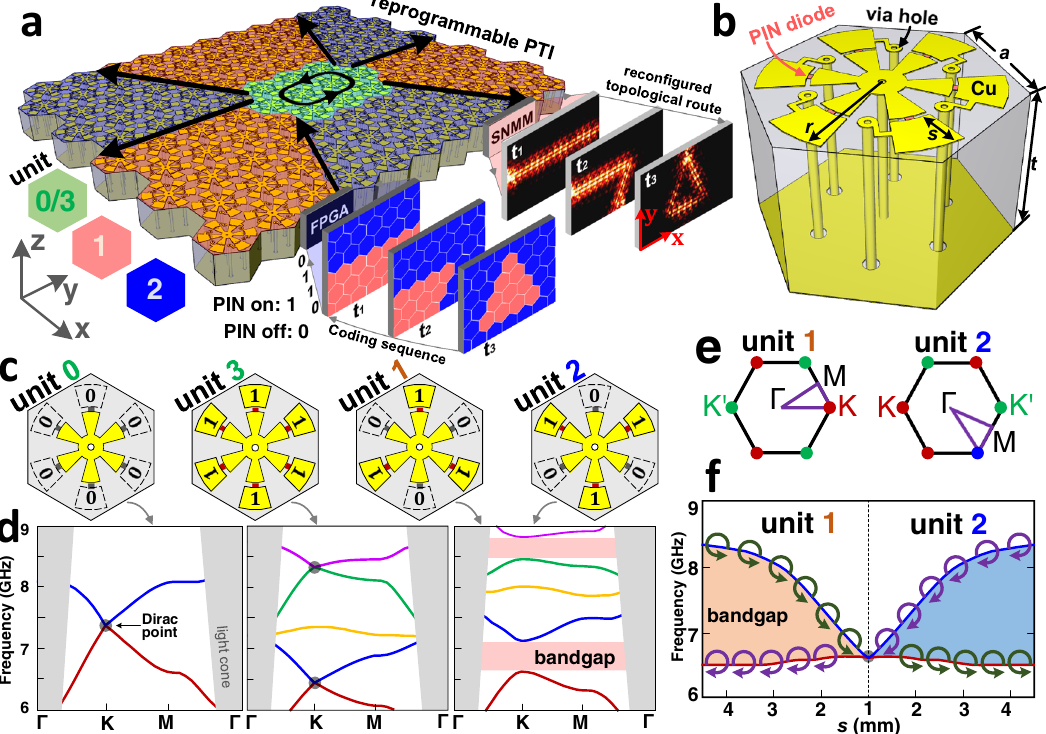
Fig. 1 Design principle of RPTI. a Schematic of an ultrafast reprogrammable plasmonic topological insulator (RPTI). The digital state of each reprogrammable unit cell is controlled electrically by the fi eld-programmable gate array (FPGA) controller, which enables one to dynamically recon fi gure the topological propagation route as needed. b Reprogrammable unit cell. A six-arm metallic element and a ground plate perforated by six via holes are printed on the two facets of a dielectric spacer. The binary states of the metallic element are controlled by six positive-intrinsic-negative (PIN) diodes (shown in red). c Four digital states of a designed 2-bit reprogrammable unit cell, whose odd (even) outer arms hold the same binary state. d Band diagrams of a crystal with the designed 2-bit unit cell. e First Brillouin zone of digital unit-1 and unit-2. f Topological phase transition and the valley-chirality property of the fi rst and second bands of digital unit-1 and unit-2. The valley bandgap is enlarged when increasing the length s of outer